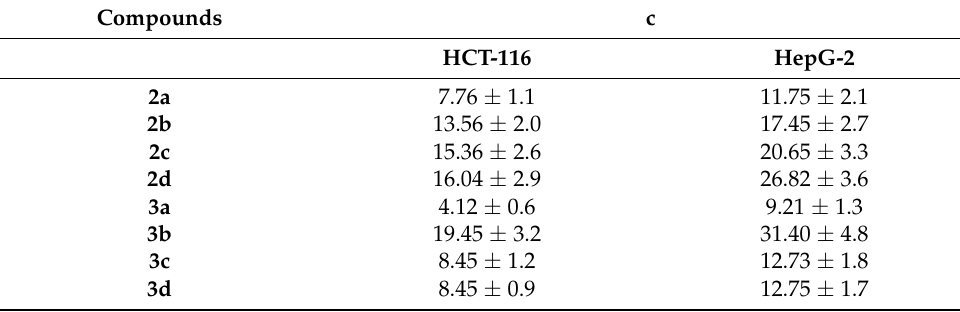
Table 3. IC 50 of the synthesized compounds on colon carcinoma cells (HCT-116) and hepatocellular